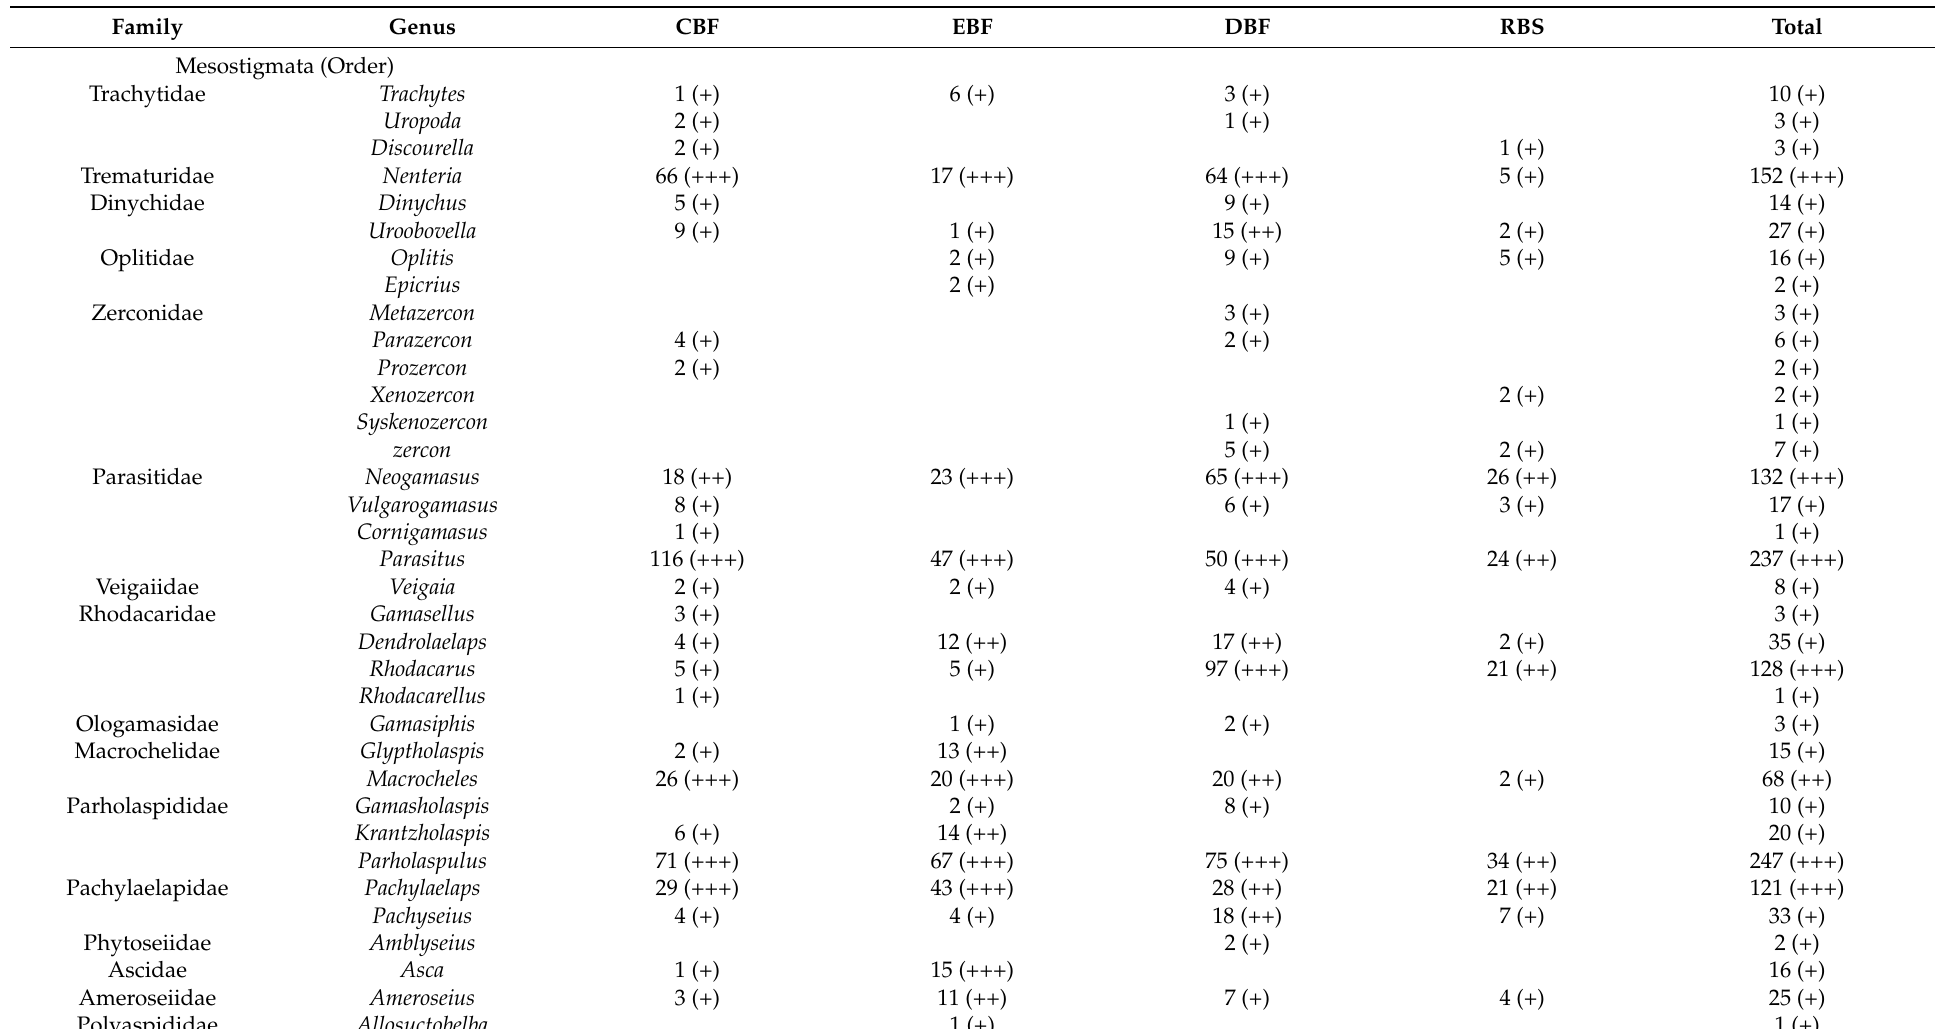
Table 3. Composition and population distribution of soil mite communities in the study